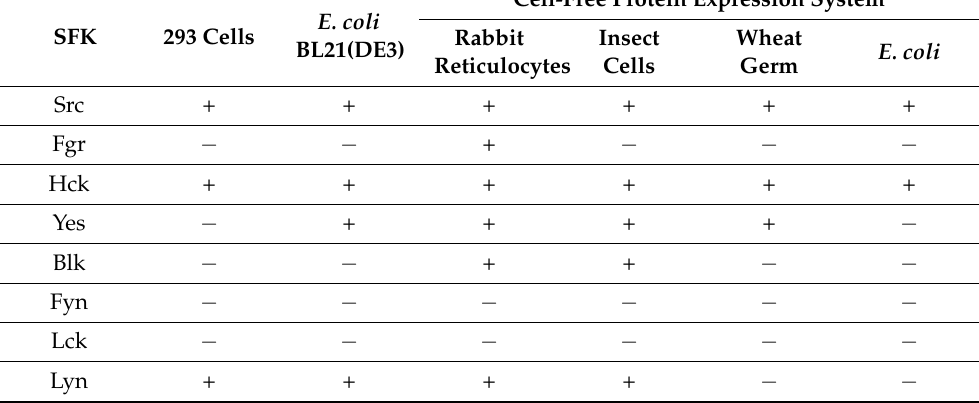
Table 2. Summary of the kinase activity of SFKs expressed in cell-free protein expression systems, 293 cells, and E. coli BL21(DE3). + or − means presence or absence of phosphorylation activity toward GST-Srctide, respectively.